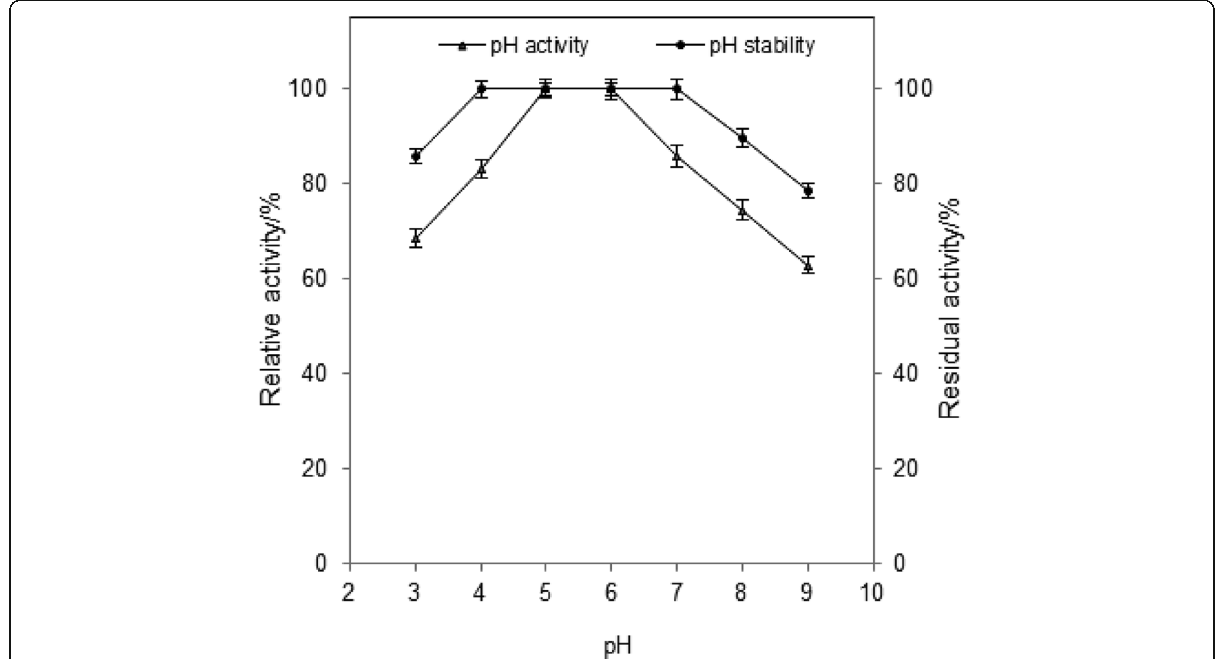
Fig. 5 Effect of pH on Aspergillus sp. DHE7 β -glucosidase activity. Optimal pH for β -glucosidase activity (filled triangles) was determined by assaying the enzyme in various pH ranging from 3.0 to 9.0, pH stability (filled circles) was determined by pre-incubating of the purified β - glucosidase (without the substrate) in the same buffers for 24 h at 4 °C and measuring the residual activity. The non-treated enzyme activity was regarded as